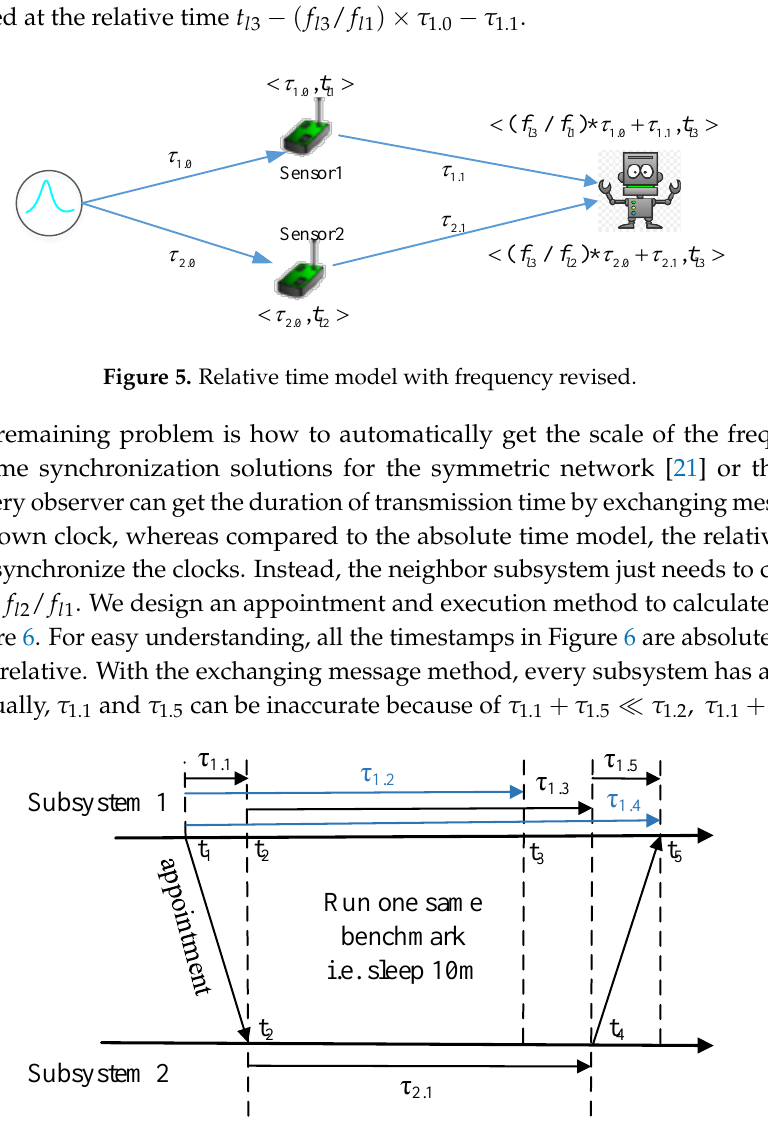
Figure 6. Appointment and execution method for relative frequency scale calculation.